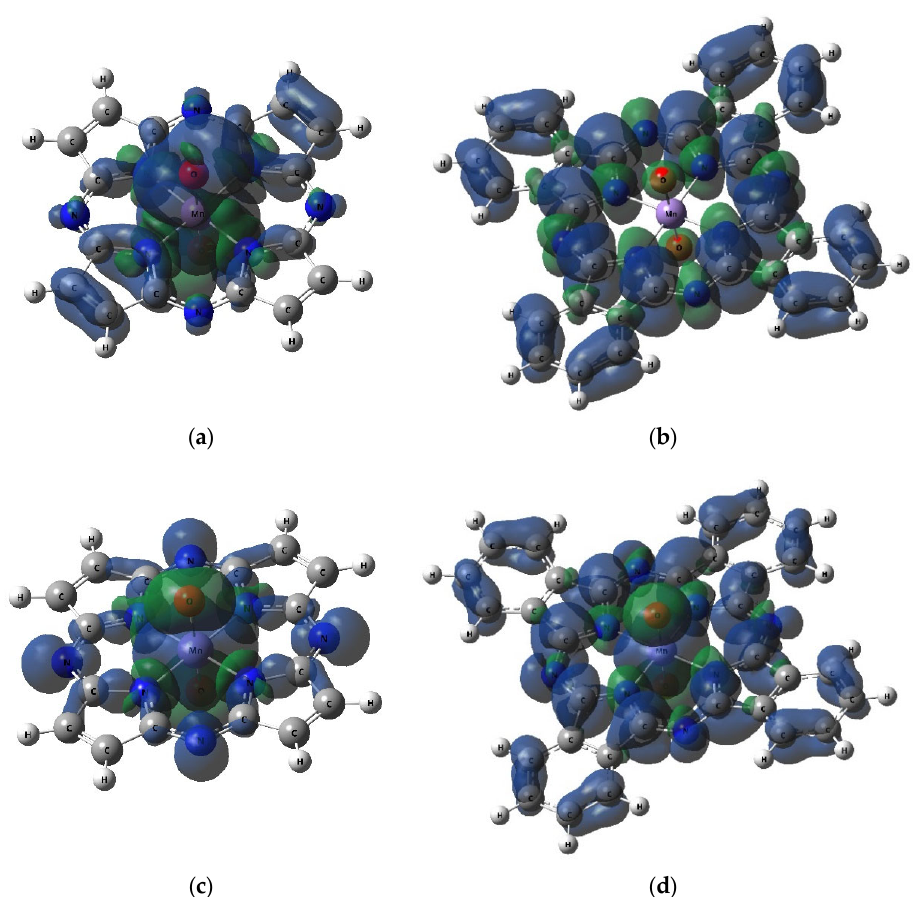
Figure 3. The pictures of spin density distribution in the [Mn( P )(O) 2 ] and [Mn( Pc )(O) 2 ] complexes obtained using the DFT B3PW91/TZVP ( a , b ) and DFT OPBE/TZVP methods ( c , d ). The standard thermodynamic parameters of formation in the framework of the iso ‐ Table 3. Standard thermodynamic parameters of formation for [Mn( P )(O) 2 ] and [Mn( Pc )(O) 2 ] com- baric process for the given macrocyclic metal chelate under examination ( Δ H 0 f , S 0 f and plexes calculated using the OPBE/TZVP and B3PW91/TZVP